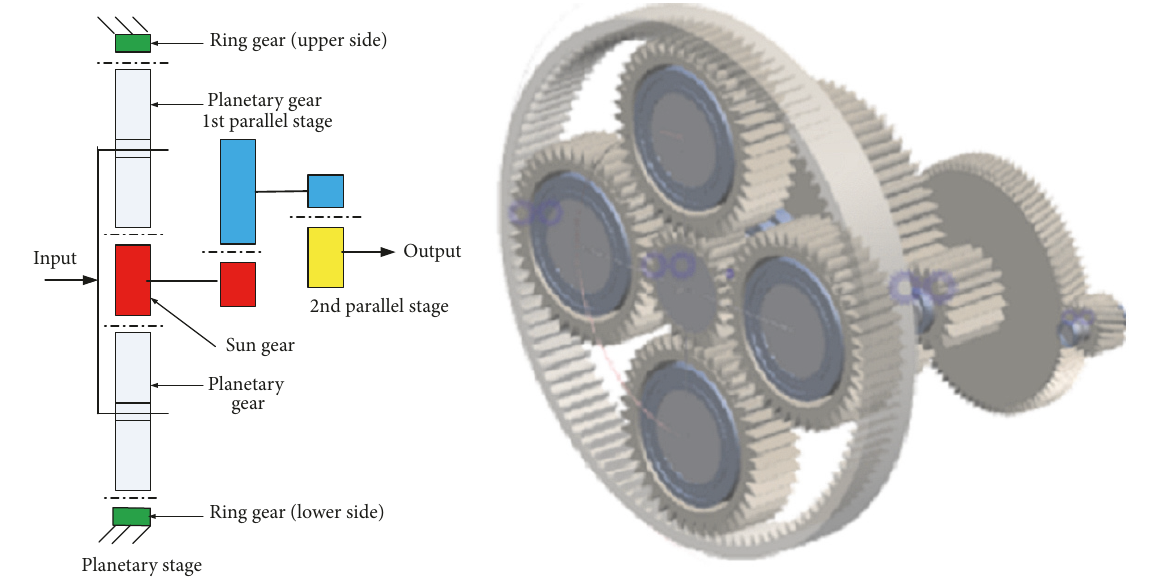
Figure 2: One-stage planetary and two-stage helical/parallel gear arrangement [6].